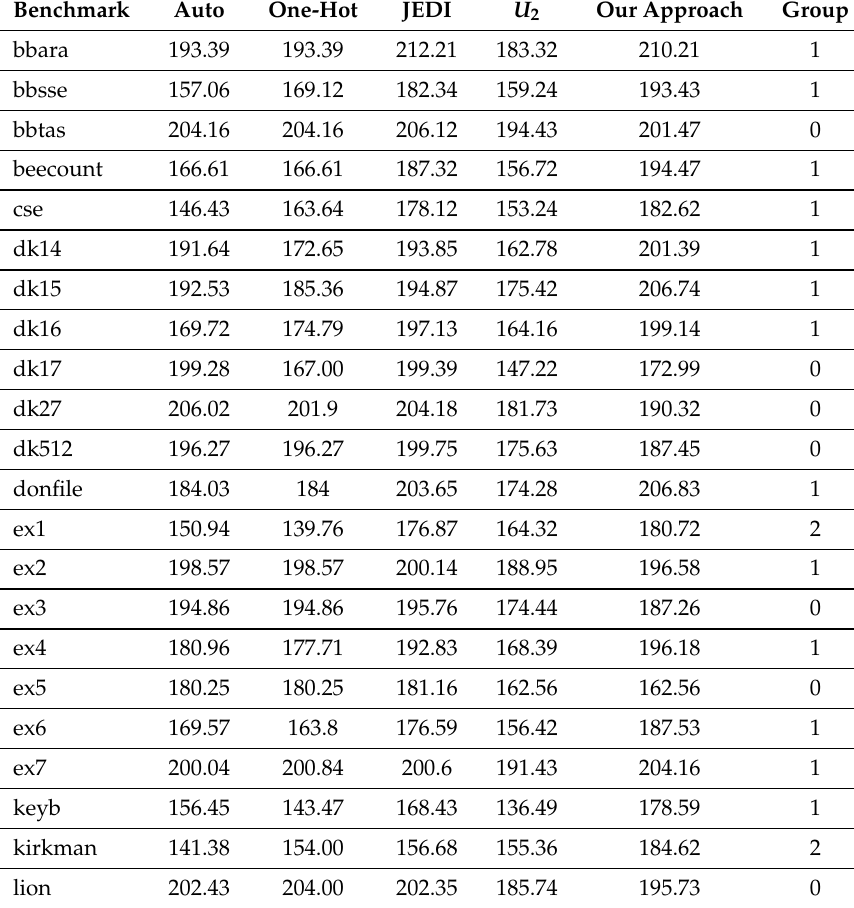
Table 8. Results of experiments (the operating frequency,